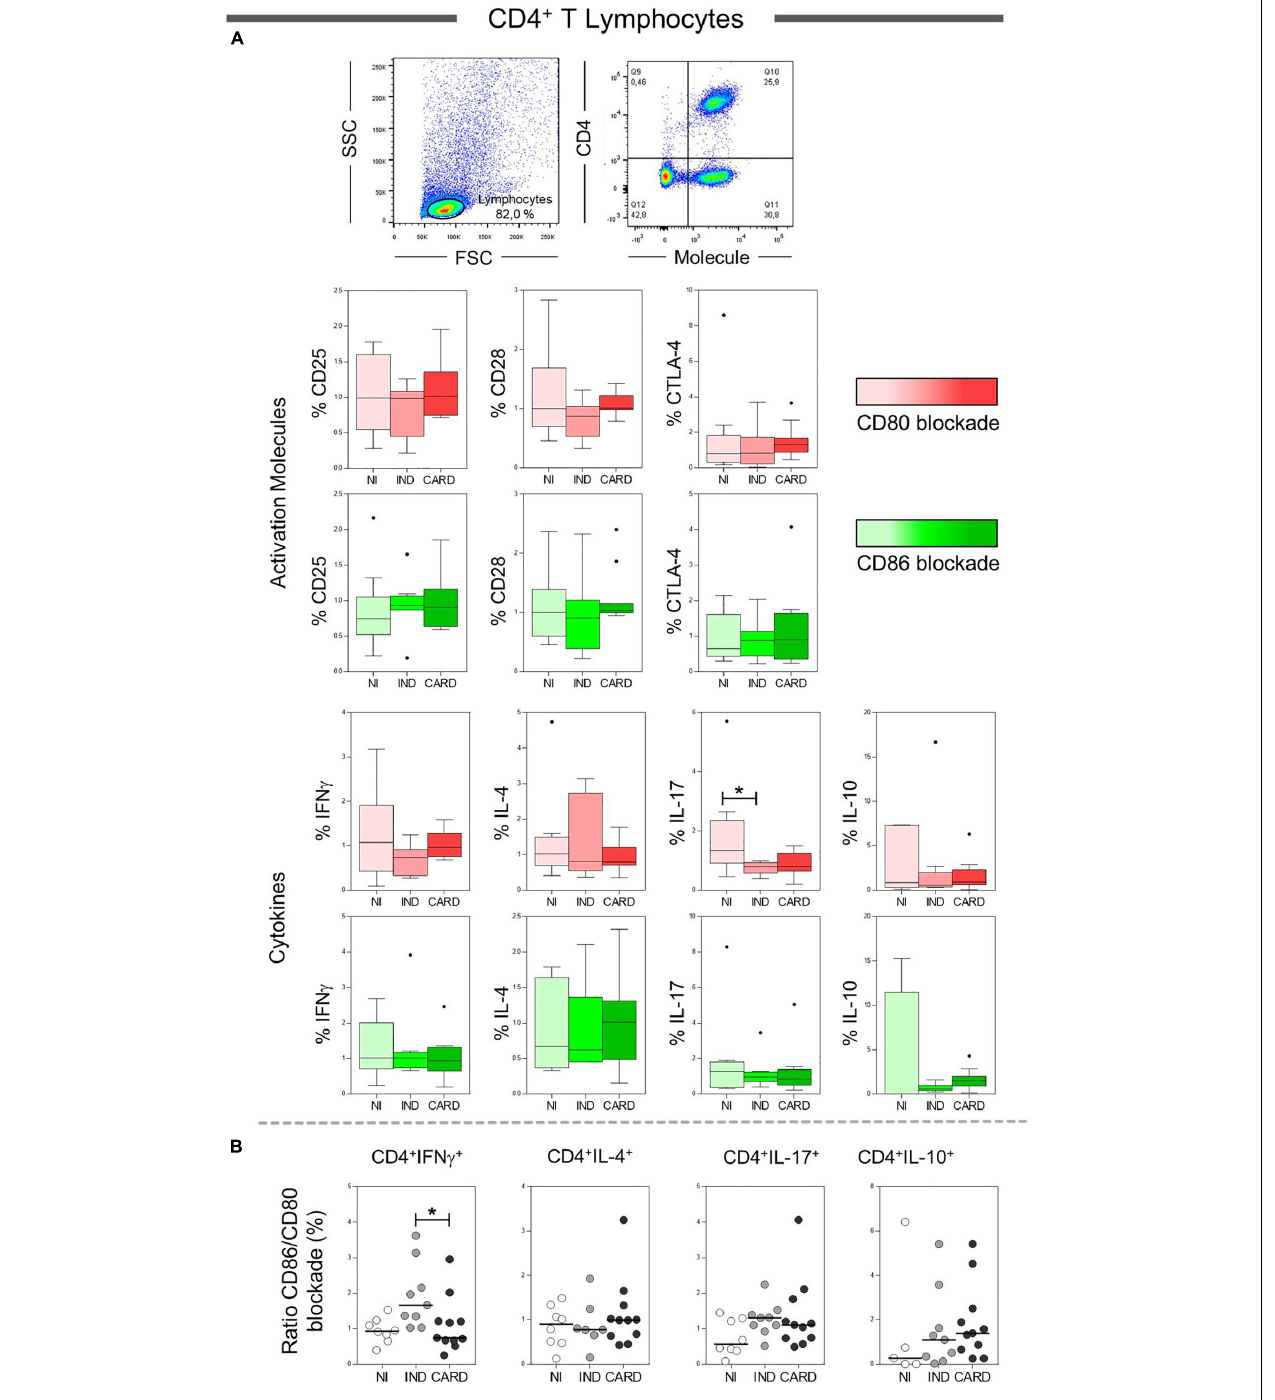
FIGURE 2 | Analysis of the phenotypic-functional profile of CD4 + T lymphocytes after anti-CD80 and anti-CD86 antibody blockade. Flow cytometry gate strategy of non-infected (NI) individuals is represented. Frequency of T CD4 + lymphocytes expressing CD25, CD28, and CTLA-4 activations molecules and IFN- γ , IL-4, IL-17, and IL-10 cytokines (A) in PBMC culture from NI individuals ( n = 9), indeterminate (IND, n = 9), and cardiac (CARD, n = 11) clinical forms of Chagas disease, after TRYPO in vitro stimulation and anti-CD80 and anti-CD86 antibody blockade. Relative expression index of IFN- γ , IL-4, IL-17, and IL-10 cytokines through CD86/CD80 blockade ratio by CD4 + T lymphocytes (B) . Statistical differences ( p < 0.05) between groups were obtained by Kruskal–Wallis test, followed by Dunn’s post-test, and represented by asterisk (*) and lines. Boxes demonstrate the median and interquartile ranges, whiskers evidence the highest and lowest observation, and dots represent the